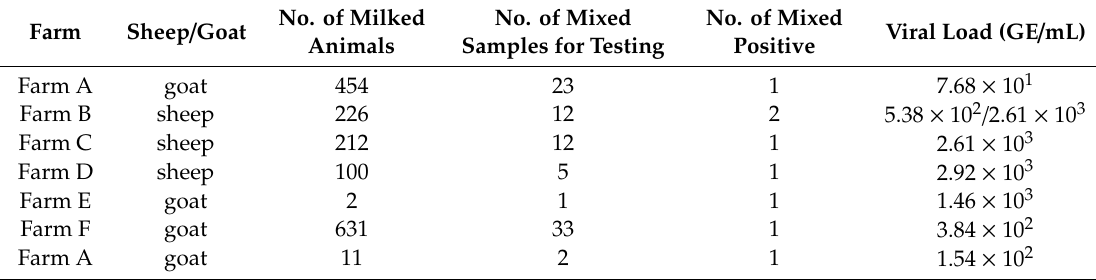
Table 1. Detection of Hepatitis E virus in ovine and caprine milk